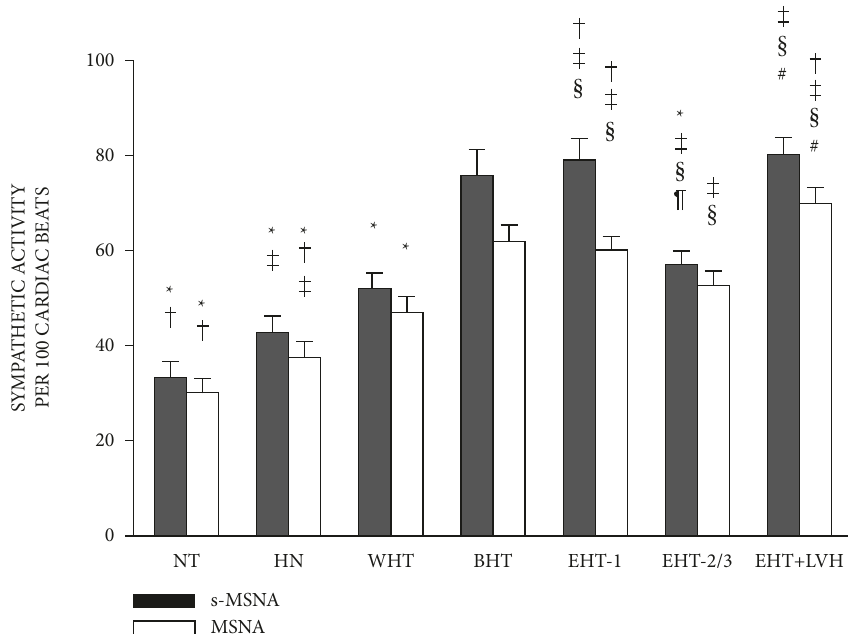
Figure 2: Multiunit muscle sympathetic nerve activity (MSNA) and single-unit muscle sympathetic nerve activity (s-MSNA), quantified per minute in seven groups. Note. ∗ p < 0 . 05 compared with borderline hypertension (BHT), † p < 0 . 05 compared with white-coat hypertension (WHT), ‡ p < 0 . 05 compared with normotension (NT), § p < 0 . 05 compared with high-normal pressure (HN). ¶ p < 0 . 05 compared with essential hypertension stage 1 (EHT-1), # p < 0 . 05 compared with EHTstages 2 and 3; LVH, left ventricular hypertrophy. Reproduced from reference